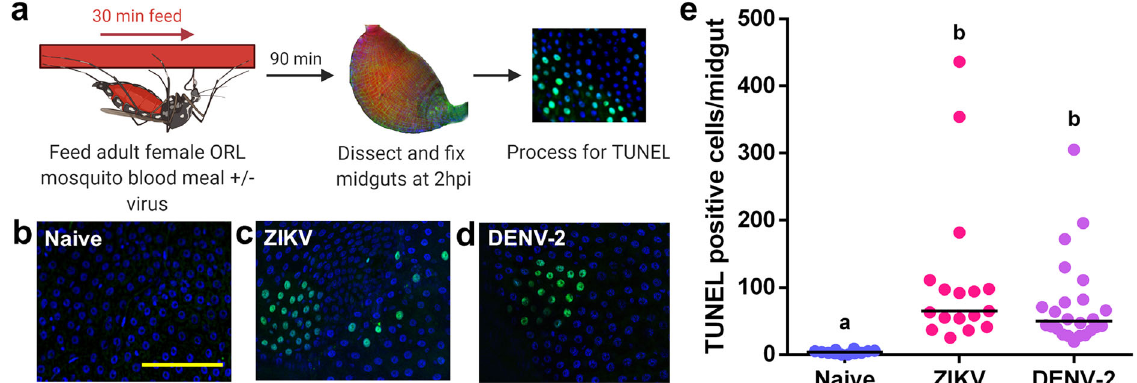
Fig. 1 Exposure to a blood meal containing DENV-2 or ZIKV induces DNA fragmentation in the midgut epithelium of adult female Aedes aegypti (ORL) mosquitoes at 2hpi. a Work fl ow diagram of in vivo infection. b – d Representative images of DNA fragmentation visualized via TUNEL with DAPI counterstain in midguts from adult female ORL mosquitoes at 2 hours post b naive blood meal c ZIKV infected blood meal or d or DENV-2-infected blood meal. Scale bar shown is 100 µ m in length and can be applied to all images. e Quanti fi cation of TUNEL-positive cells per midgut at 2 hours post in vivo infection ( n (naive) = 12; n (ZIKV) = 17; n (DENV-2) = 24). The horizontal line indicates the median. Treatments without a common letter were found to be statistically signi fi cant ( α = 0.05) as calculated by Kruskal – Wallis test with Mann – Whitney post hoc comparison (Kruskal – Wallis chi-squared =